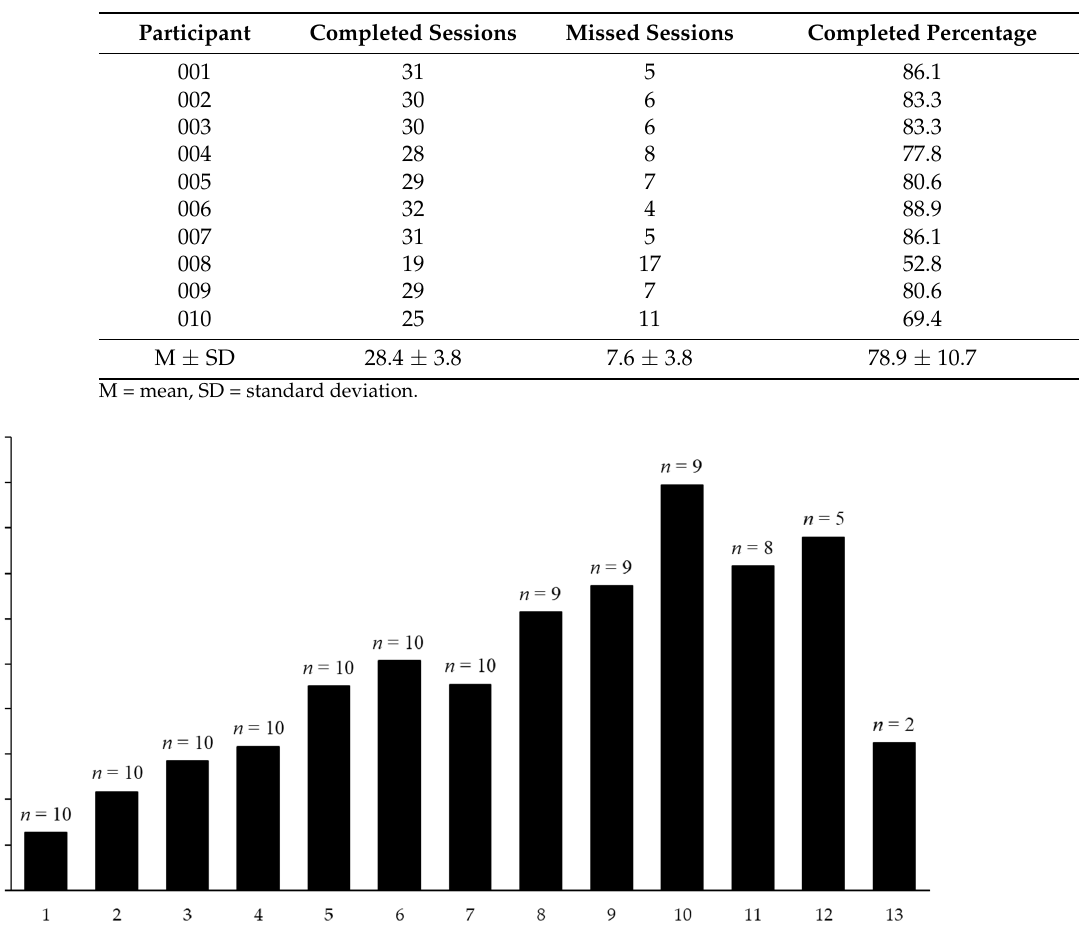
Table 2. Resistance exercise session compliance.